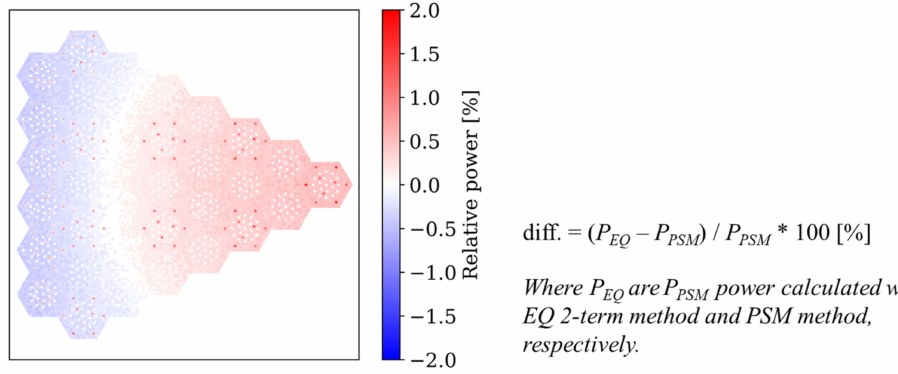
Figure 18. Pin power difference with different resonance treatment.